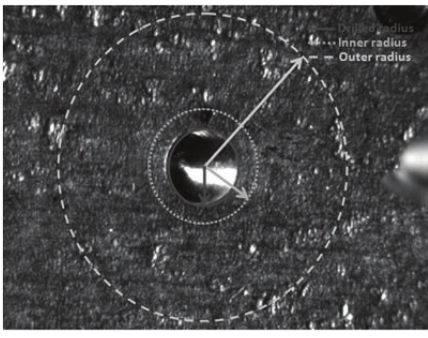
Figure 2: Screenshot of the area of analysis included between the outer circle (dashed line) and the inner circle (dotted line). The solid line identifies the drilled